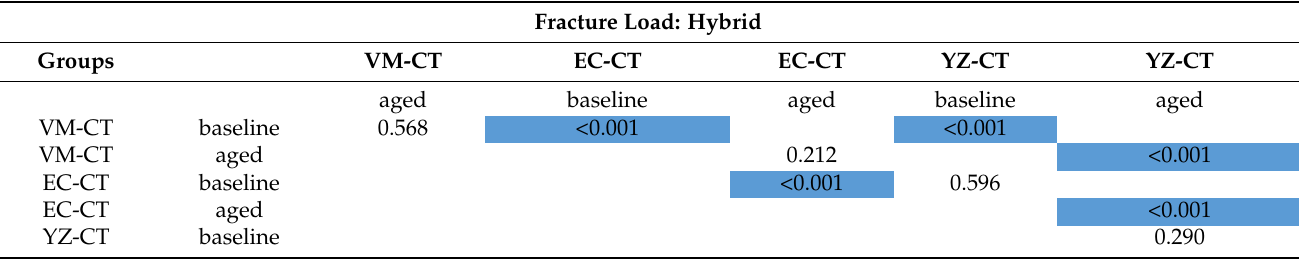
Table A1. Fracture load: p -values (colored: significant difference p <